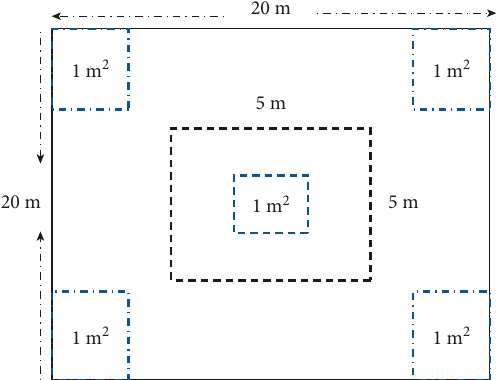
Figure 4: Sampling design used in data